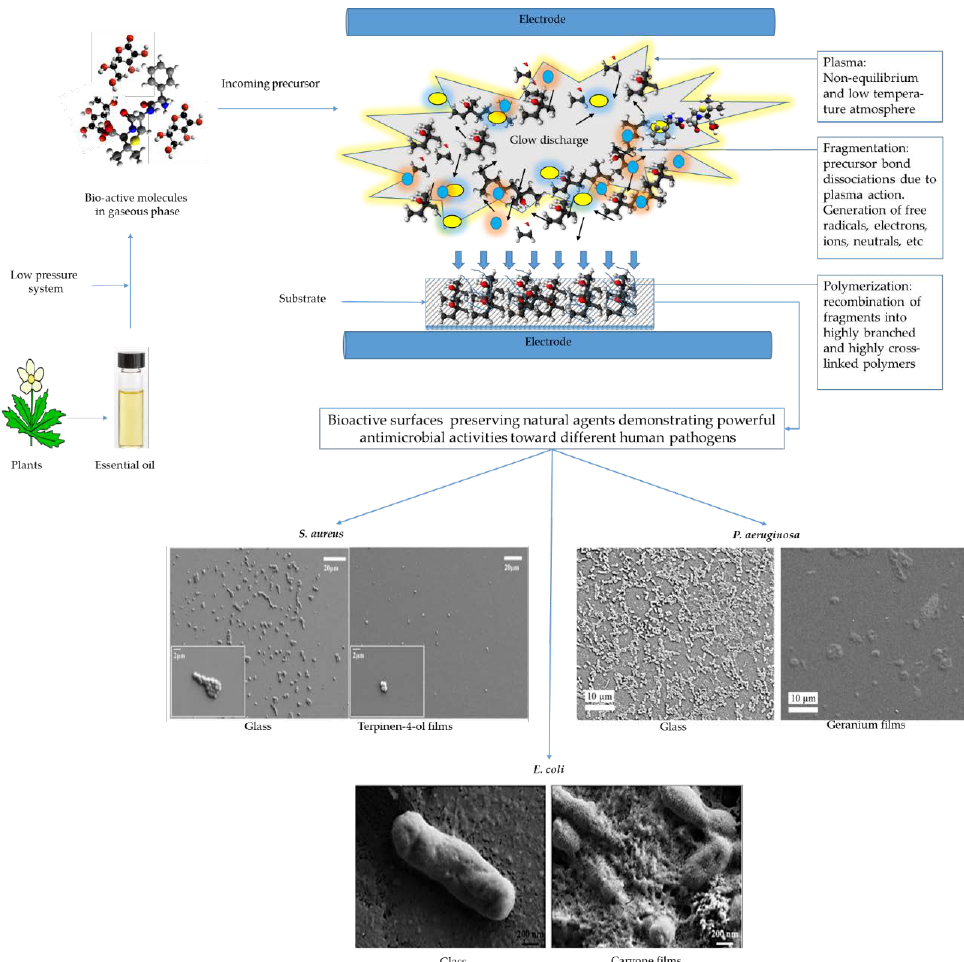
Figure 3. Representative examples of plasma polymerization of plant secondary metabolites, where retention of the antimicrobial activity was achieved. As soon as a bioactive secondary plant metabolite (or an essential oil) is placed under low pressure, the molecules gain sufficient kinetic energy to separate and begin independently moving towards the glow region within the deposition chamber. Exposure of the molecules to the highly reactive plasma initiates various chemical reactions, such as bonds fragmentation, oligomerization, and polymerization. At the chosen plasma parameters, the process allows for the preservation of active functional groups of PSMs within the cross-linked solid polymeric films. Direct observations of SEM demonstrated the powerful antimicrobial performance of geranium, terpenen-4-ol, and carvone films in contact with different pathogens. The antimicrobial activities of these films included antibiofouling effects and/or bactericidal actions (e.g., membrane distortion, pores creation, and membrane damage). The SEM images are reproduced with permission from